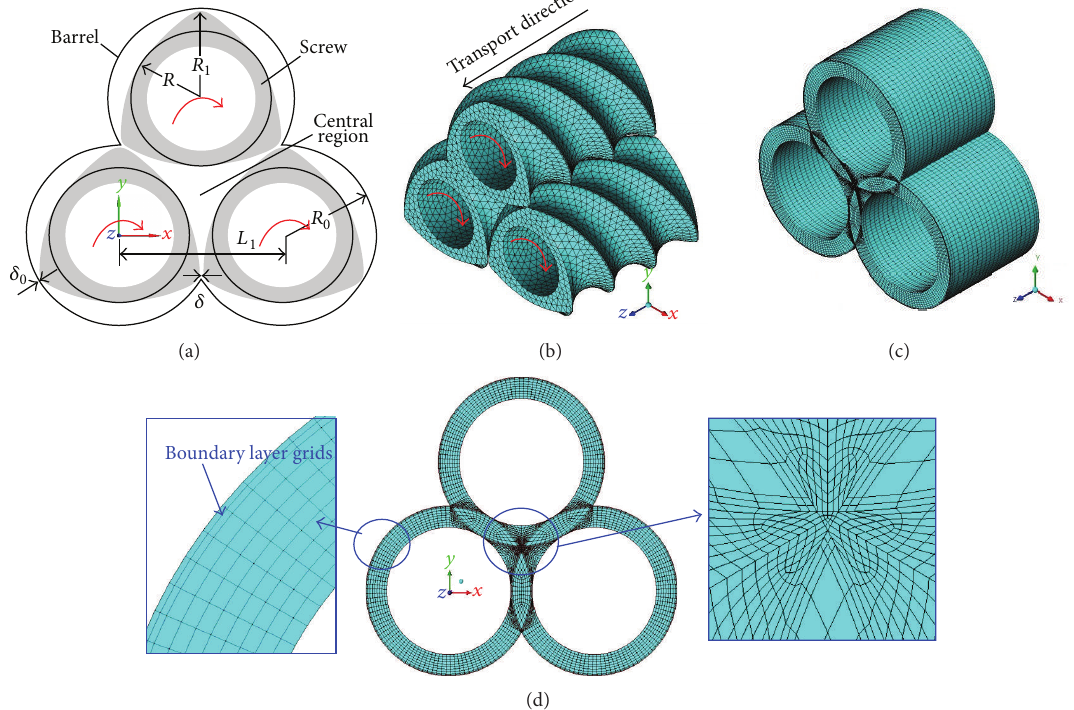
Figure 1: Geometric and finite element model of the tri-screw extruder: (a) geometric model in cross section; (b) grids of three screws in isometric view; (c) grids of the runner in isometric view; (d) grids of the runner in cross section.